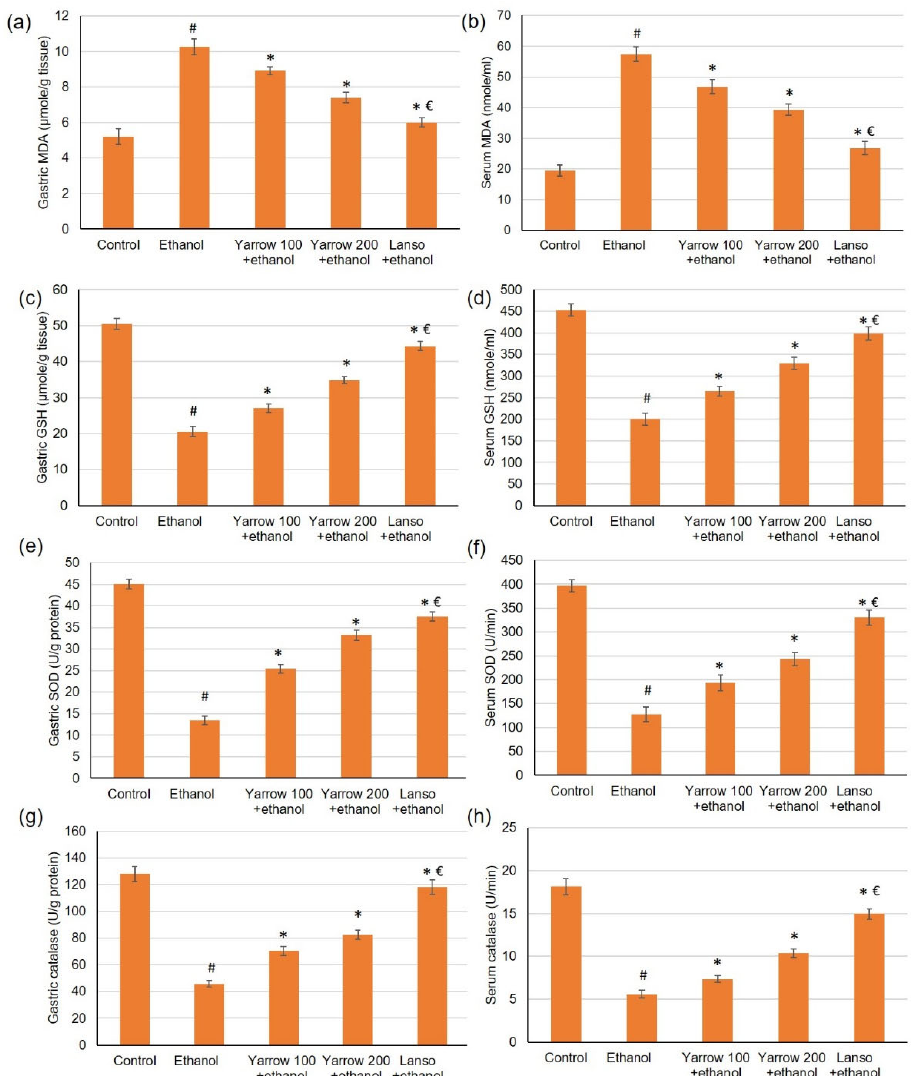
Figure 5. Effects of YEO (100 and 200 mg/kg) administration in acute gastric mucosal injuries induced by ethanol in rats on gastric and serum of ( a , b ) MDA, ( c , d ) GSH, ( e , f ) SOD and ( g , h ) catalase, respectively. All data are quantified as mean ± SE, ( n = 6 ). (#) defines statistically significant related to the control, (*) signifies statistically significant related to the ethanol ‐ induced gastric mucosal injuries, and (€) designates statistically significant related to YEO 200 + ethanol via one ‐ way ANOVA afterward Tukey’s post hoc test ( p < 0.05).